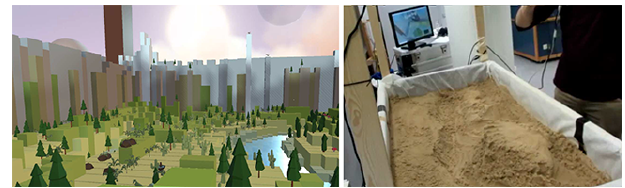
Figure 10. The landscape can be shaped by interacting with real sand (Right). VRBox from first person perspective (Left).